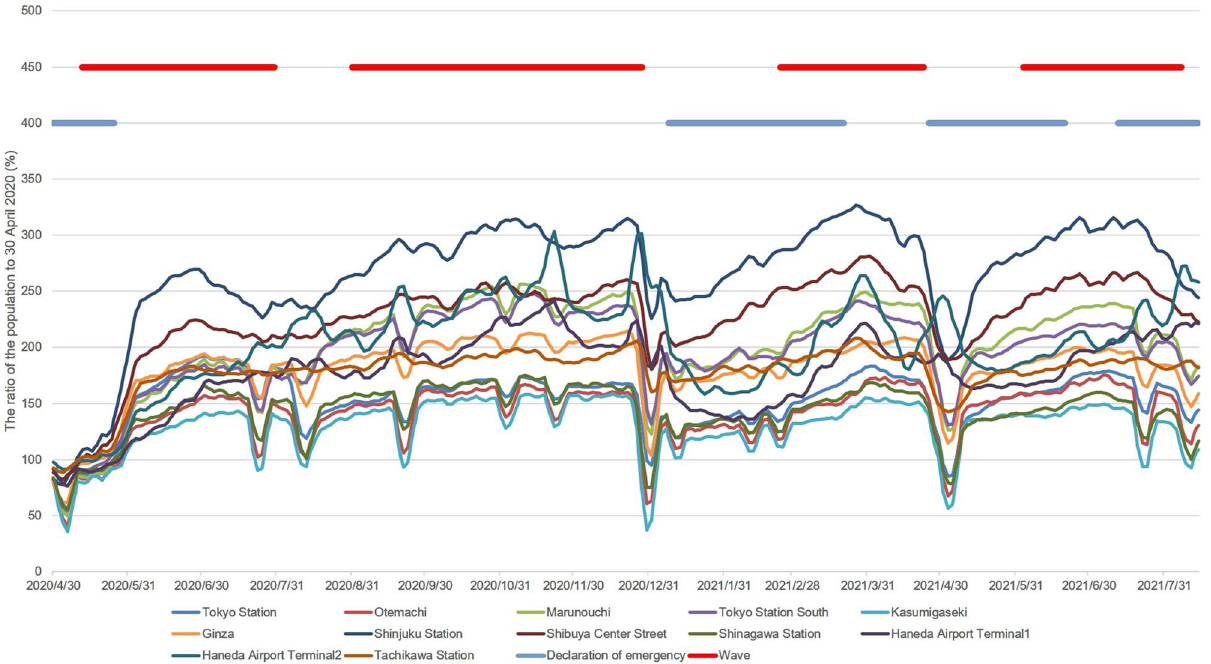
Figure 4. Trends in the number of people at 12 sites, the period of emergency declarations and the period of waves. Only the trend component of the number of people at 12 sites (thin lines) and the period of emergency of declaration (thick blue line) and wave (thick red line) are